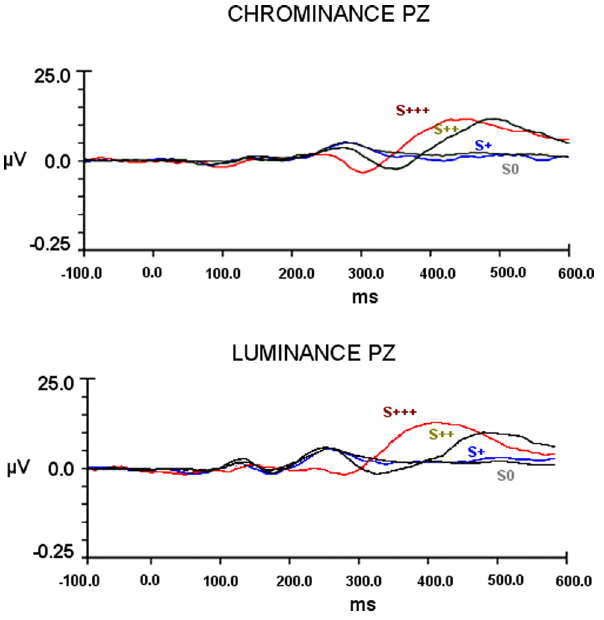
Figure 3. Grand-average ERPs for Experimental Session I (experiments I and II): evidence for saliency related response modulation. Larger and faster responses are evoked by most salient stimuli. Grand-average ERPs’, time locked for target category level, are shown for the representative PZ electrode and referenced to earlobes. Amplitude in microvolts ( m v) is plotted against time (ms). S0 – ERPs for Standard stimulus; S + ERPs for minimal saliency manipulation; S ++ ERPs for intermediate saliency manipulation; S +++ ERPs for the maximal saliency manipulation. Top: ERP average waveforms for the Color/ Luminance experiment. Bottom : ERP average waveforms for the for Phase Offset experiment. Differences between S0 and S + average ERPs were found exclusively for phase offset condition, the only one where stimuli reached conscious access, thereby matching behavioral data (Tables S2 and S7 in File S1; and Fig. 2).